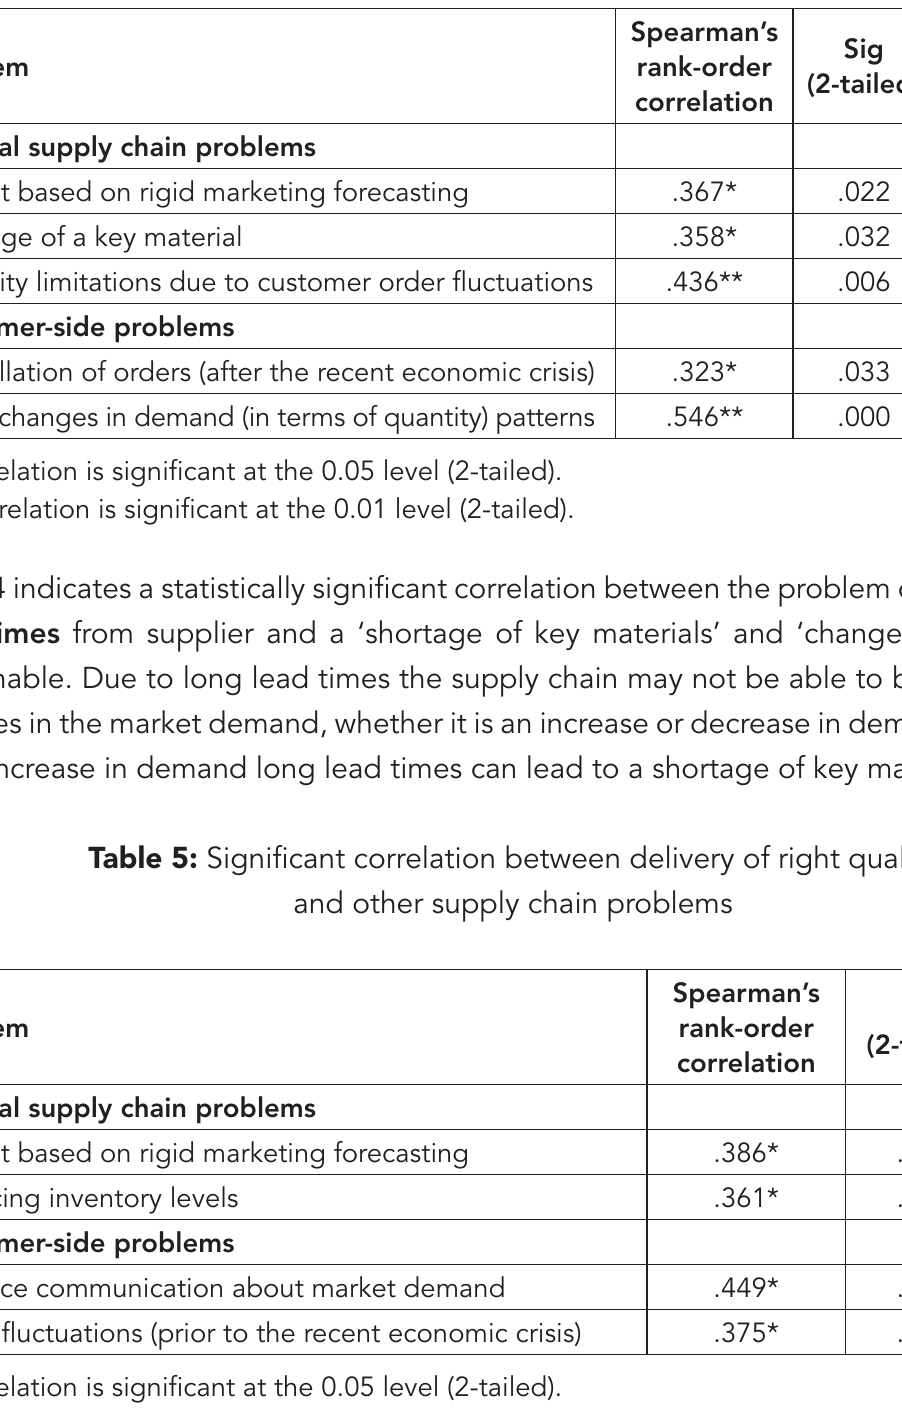
Table 4: Significant correlation between long material lead times and other supply chain problems